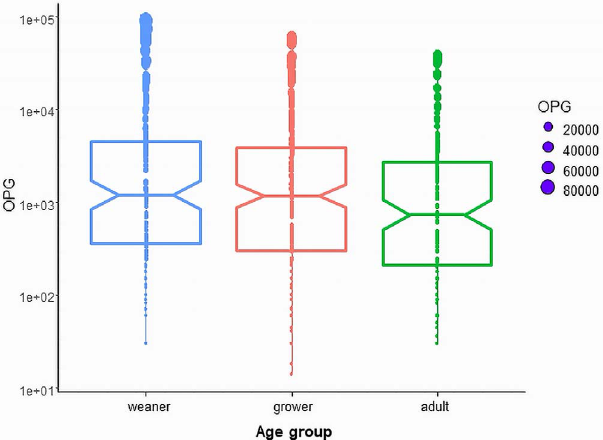
Figure 2. Intensity of coccidian infection (OPG) was higher in weaners than fatteners and growers ( p < 0.05). The top and bottom horizontal lines of boxplots represent the fi rst and third quartiles of the data range, respectively. The medians are shown by middle horizontal lines, and the data range is shown by vertical lines, with outliers plotted as points. The notches of each boxplot are approximate 95% con fi dence intervals of medians. OPGs are described in log